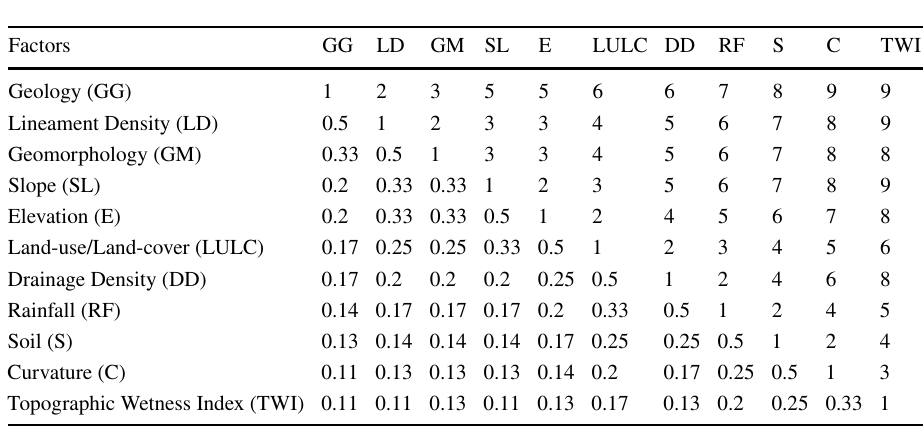
Table 4 Pair-wise comparison matrix, weights and consistency ratio for the data layers used Thematic Layer Geology